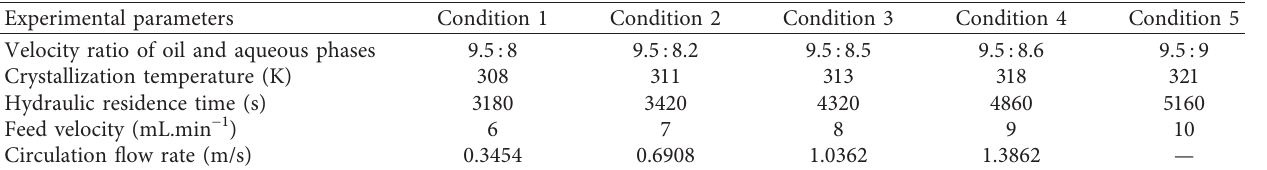
Table 1: Experiment conditions.